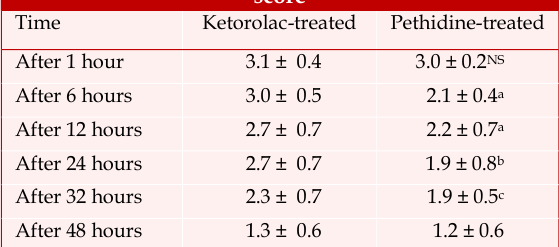
Assessment of post-operative pain relief by VRS